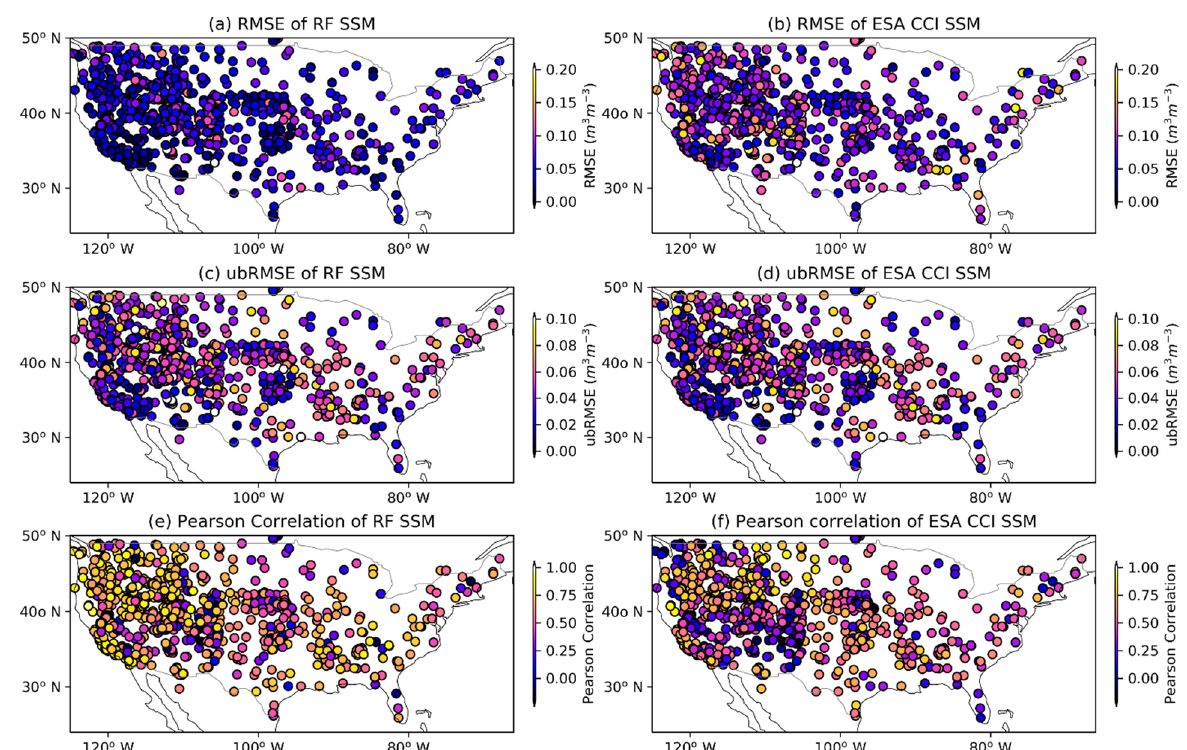
Figure 8. Mean statistical metrics distribution of RF SSM and ESA-CCI SSM at the regional scale for the evaluation period.